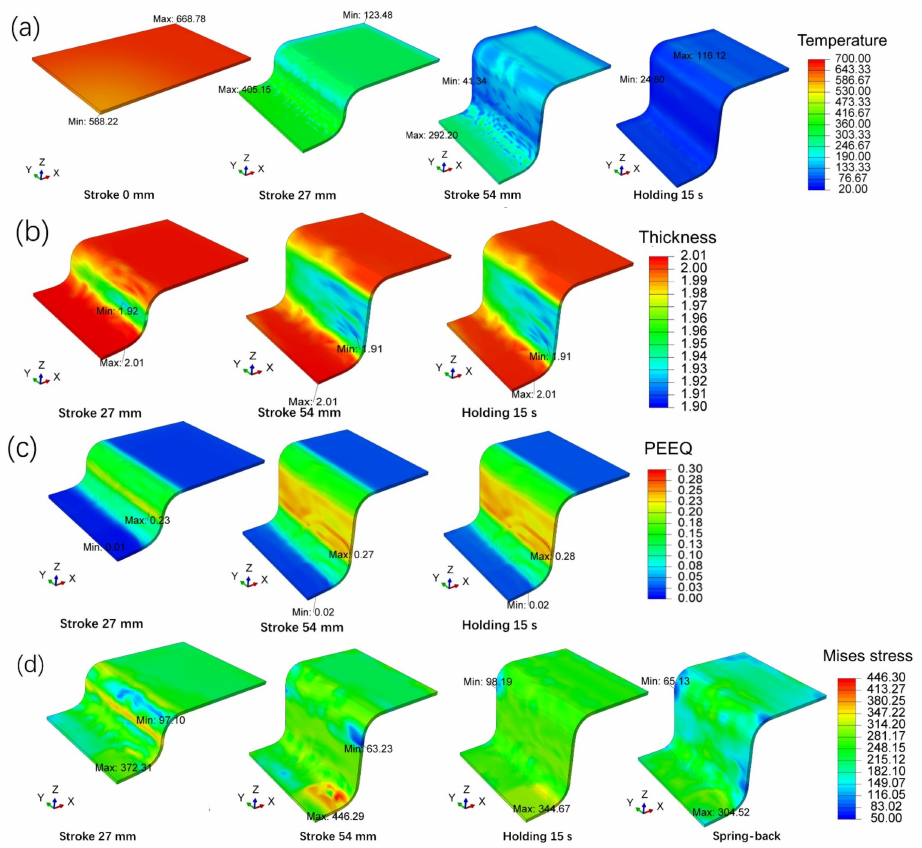
Figure 24. ( a ) Temperature; ( b ) Thickness; ( c ) Strain; ( d ) Stress with TPP-S.